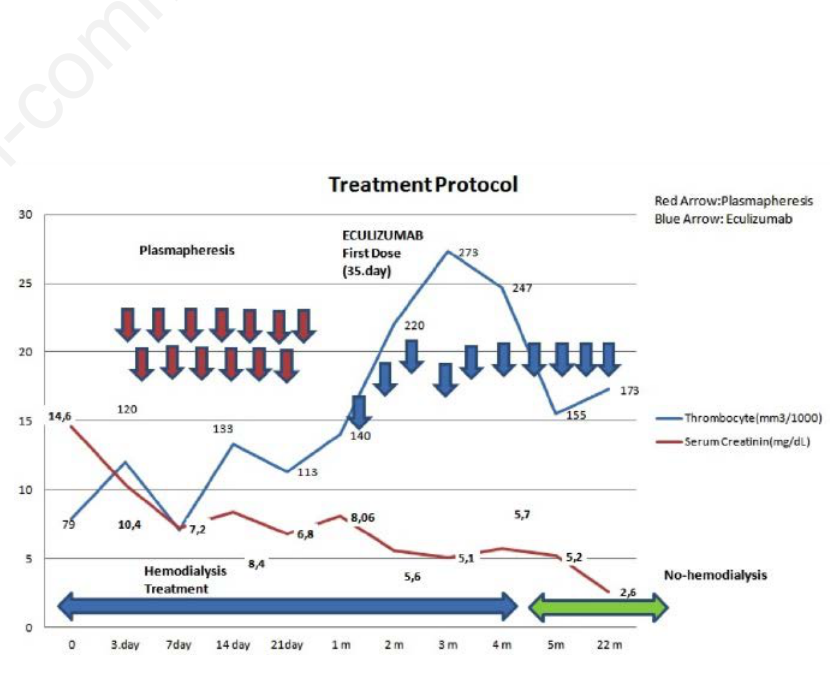
Figure 3. Platelet counts were normalized and serum creatinine level decreased after eculizumab